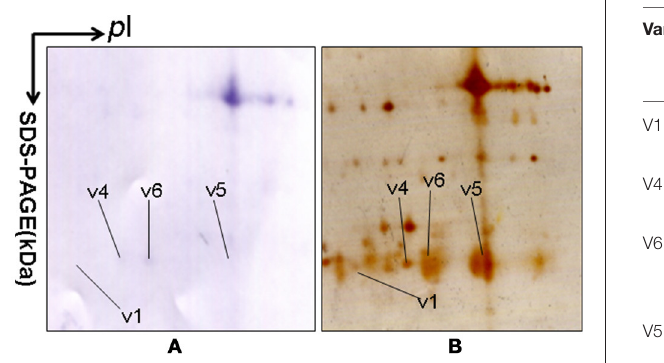
TABLE 4 | Tryptic peptides of prolactin identified with mass spectrometry. Variant No. Tryptic